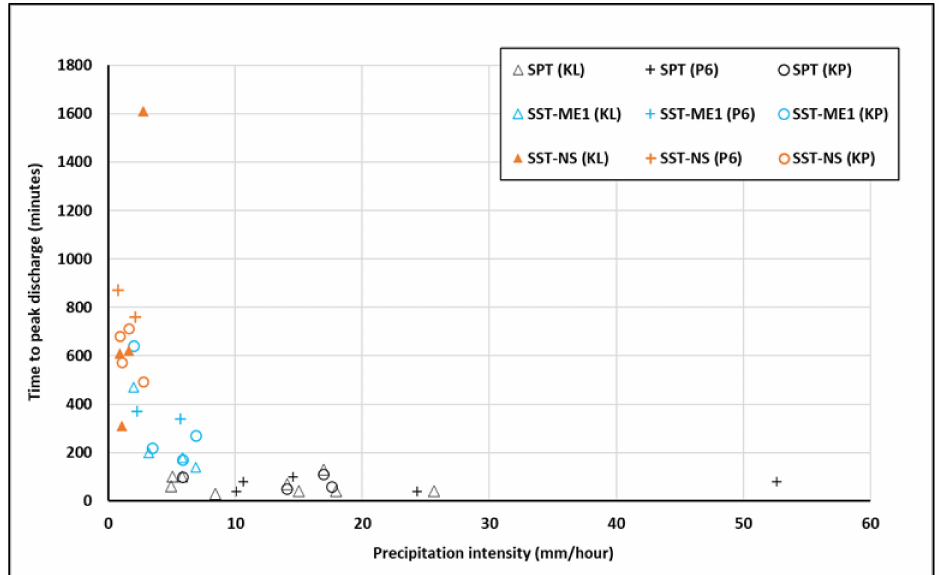
Figure 7. Relationship between the mean intensity of precipitation and the time to peak discharge of individual